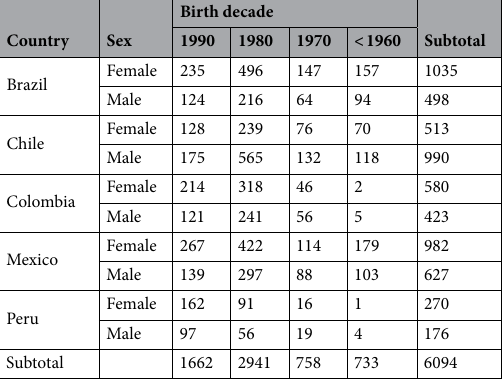
Table 1. Sample composition, size, countries, sex and birth